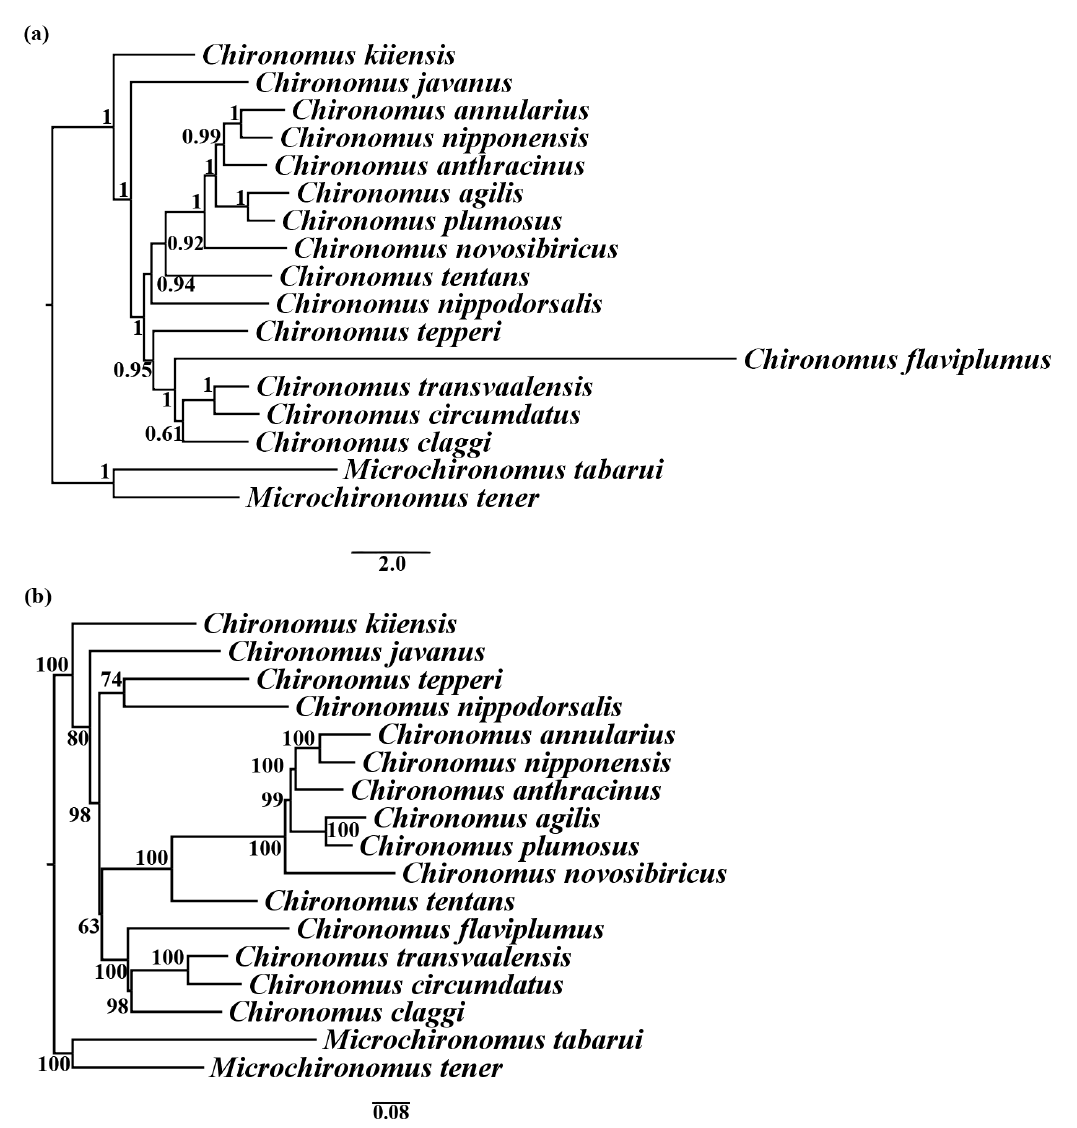
Figure 5. Phylogenetic trees of Chironomus inferred from the PCG123R dataset. ( a ) BI tree. Numbers at the nodes were BI posterior probabilities. ( b ) ML tree. Numbers at the nodes were ML bootstrap values.